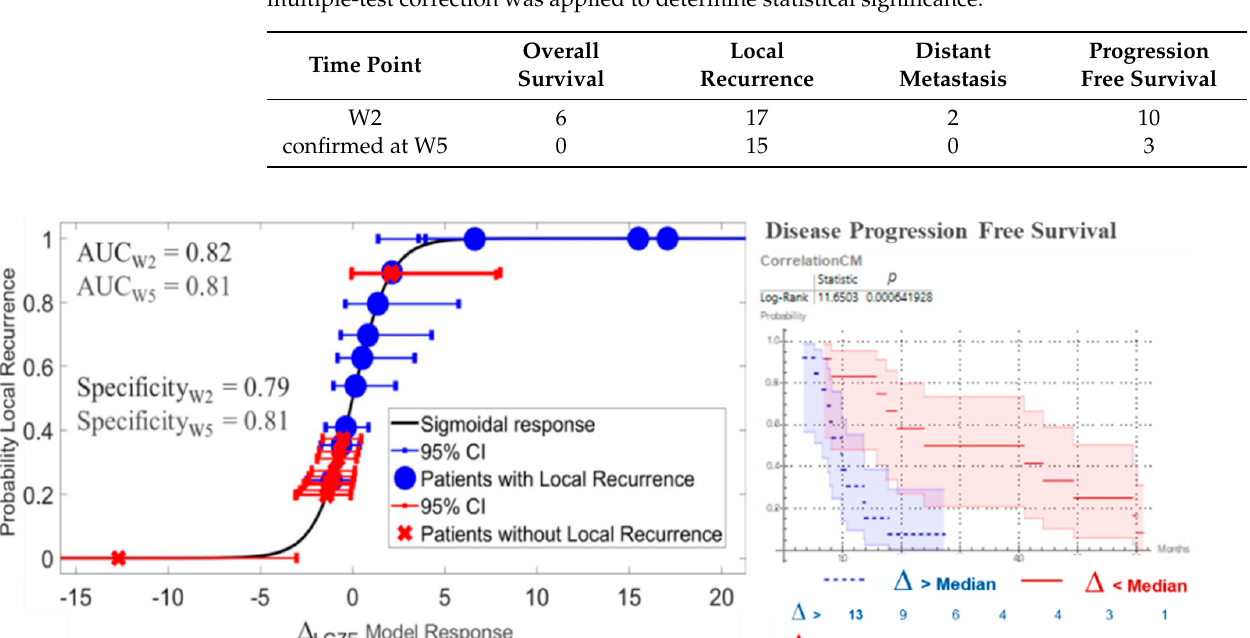
Figure 3. Kaplan–Meier curves and log-rank test for CP predicting progression free survival for head and neck cancer patients, with 18F-FMISO PET/CT at second week ( a ) and at fifth week ( b ) of chemoradiotherapy. Table 3. Number of FMISO radiomic features able to predict treatment outcome. Benjamin–Hochberg multiple-test correction was applied to determine statistical significance.